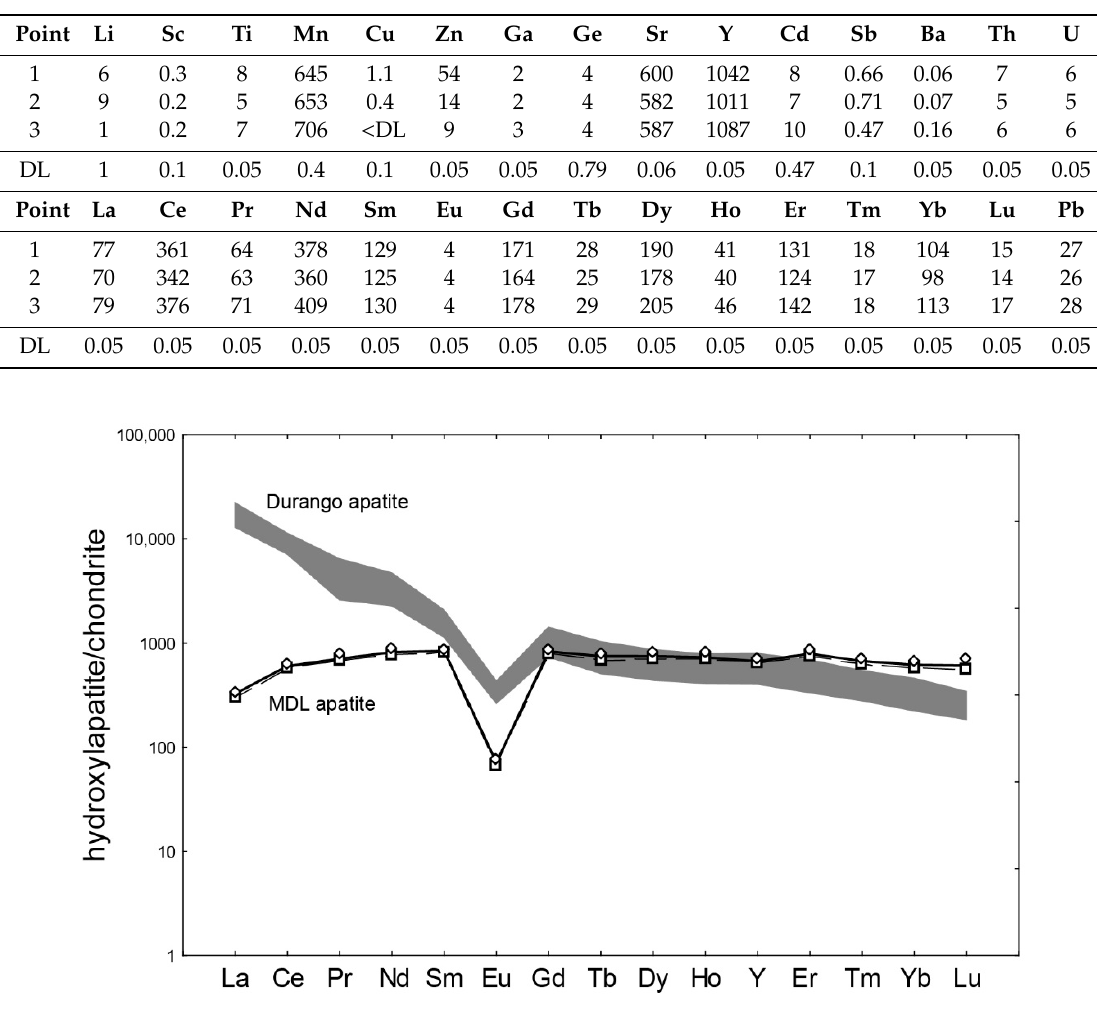
Table 3. The trace-elements contents (in ppm) in hydroxylapatite from Mur á nska Dlh á L ú ka measured by laser-ablation inductively coupled plasma mass spectrometry (LA–ICP–MS; DL—limit of detection, < DL—content below the detection limit of respective element).